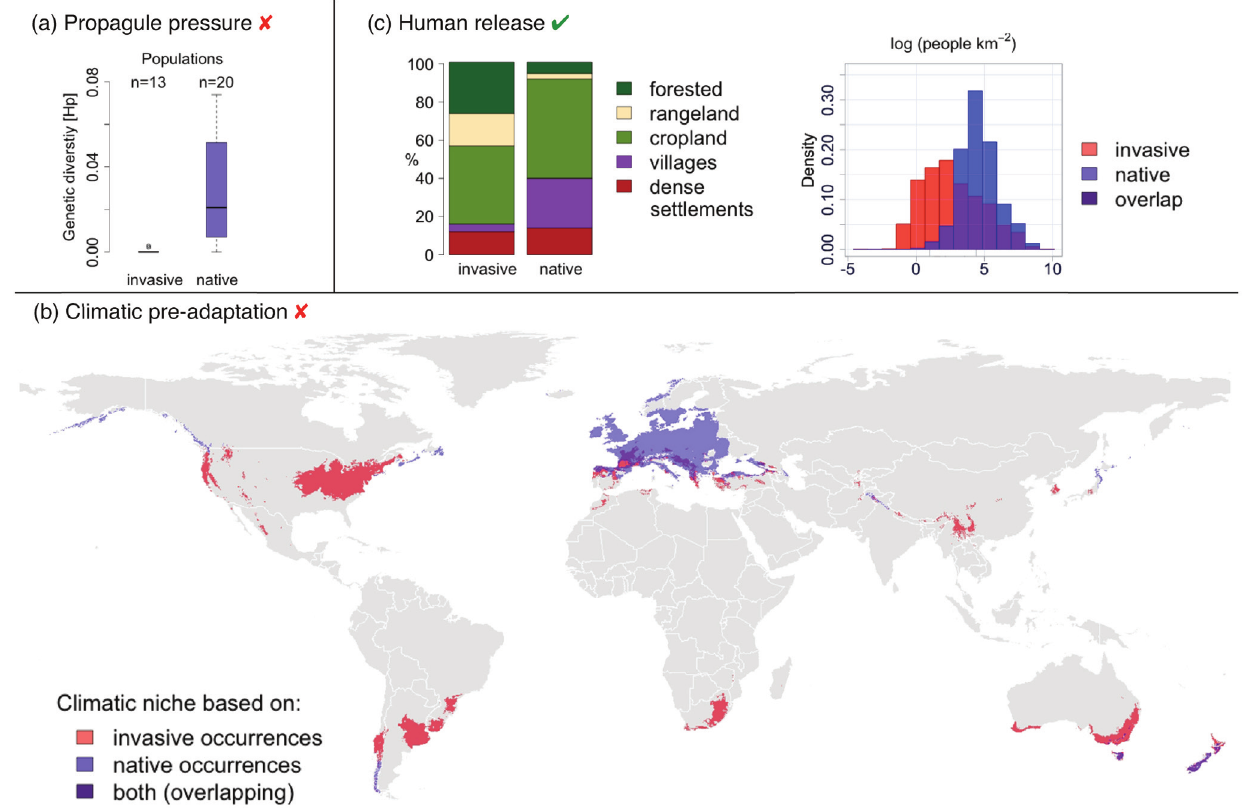
Figure 2. Rosa rubiginosa benefits from human release. ( a ) Genetic diversity in Rosa rubiginosa is higher in its native Spanish and German populations than in the introduced populations in Argentina, suggesting the species did not benefit from multiple introductions (for details see Zimmermann et al. 2010) 34 . ( b ) The species does not benefit from a climatic pre-adaptation to the new range. The world map shows the species’ climatic niche based on the species’ native distribution (blue) and the invasive distribution (pink). Overlap of climatic niches (purple) is minimal. ( c ) Rosa rubiginosa appears to benefit from “human release” in its new range. The barplot shows the global proportions of different anthropogenic biomes 10 according to the location of invasive and native sweetbriar rose populations. The native range has a larger proportion of residential areas and a higher human population density (log people/km 2 ). Only 0.56% of the invasive range is wildlands, and only 0.03% of the native range. they invaded in the alien range, but instead indicate that R. rubigi- nosa is able to thrive under a wide range of conditions